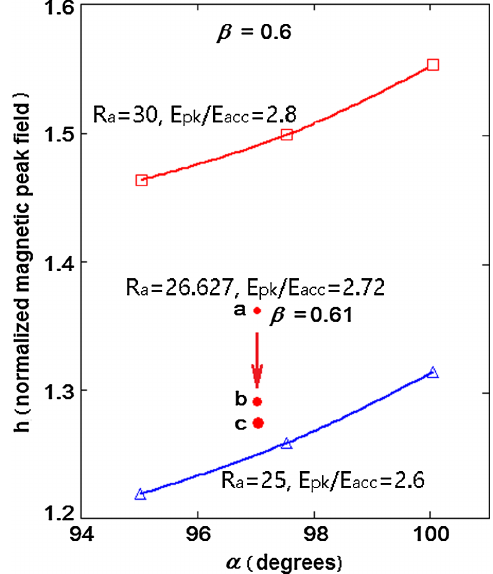
FIG. 21. Normalized magnetic peak field for different angles of the wall slope for β ¼ 0 . 7 .